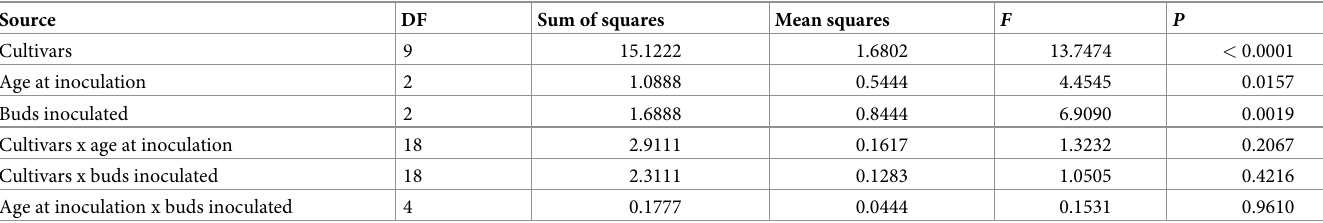
Table 3. Analysis of variance of CMD severity for age at inoculation and inoculum dose.